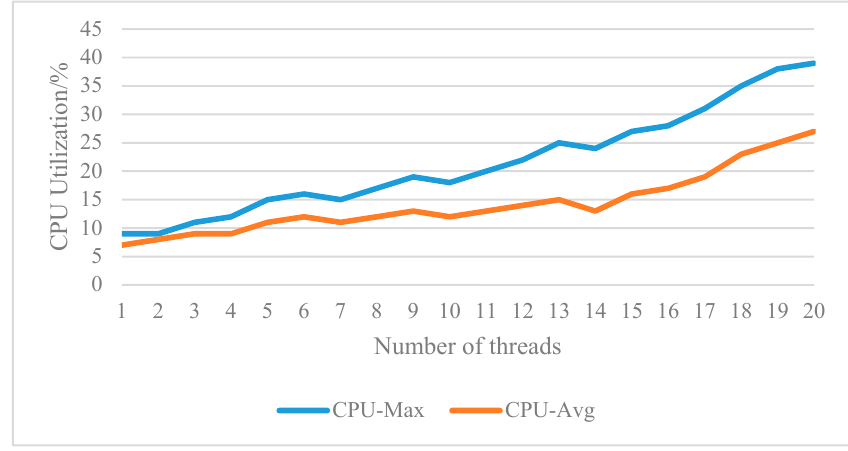
Figure 13. Central processing unit (CPU) utilization (%).